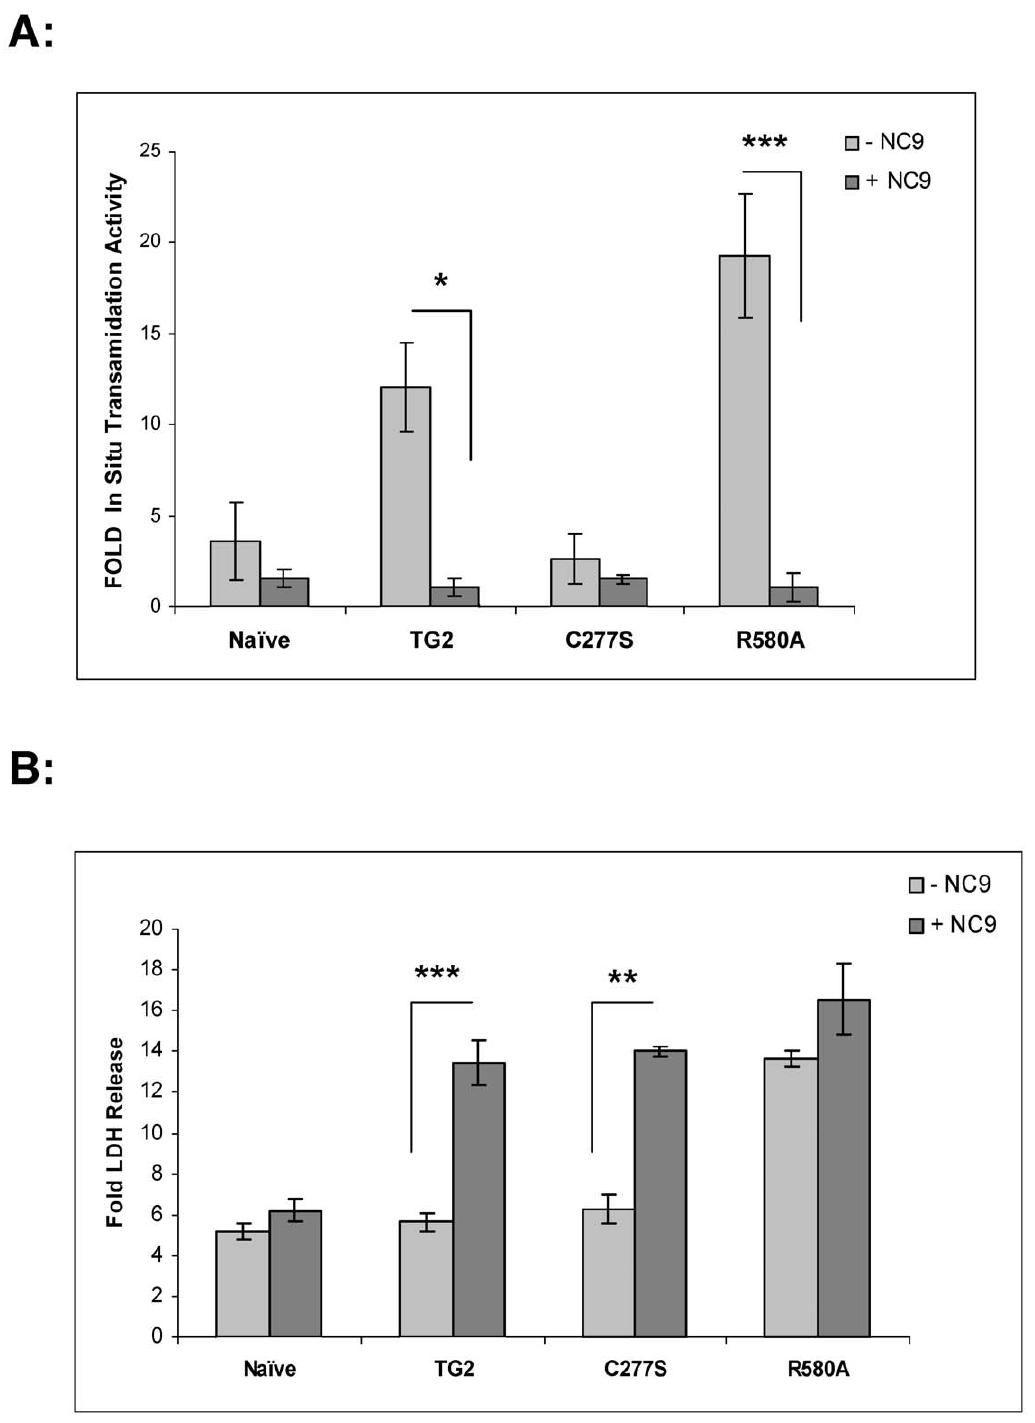
Figure 8. OGD-induced cell death with NC9 treatment. A , Fold in situ transamidation activity with ionomycin treatment in the absence ( 2 ) or presence ( + ) of 10 m M NC9 (Irreversible TG2 inhibitor) in comparison to basal in situ transamidation activity of the corresponding cell line. TG2 cells (12 fold) and TG2-R580A cells (19 fold) showed potentiation of in situ transamidation activity with 5 m M ionomycin treatment which was inhibited 100% by NC9 treatment (N=3). B , Fold LDH release after 36 h of OGD treatment at 0.1% O 2 in the absence ( 2 ) or presence ( + ) of 10 m M NC9 (TG2 inhibitor) in comparison to percent LDH release amount of corresponding cell line at normoxia. TG2 and TG2-C277S (C277S) cells showed significant increases in fold LDH release with NC9 treatment. (N=4) Results are shown as mean + / 2 SE, *p , 0.05, **p , 0.01, ***p , 0.001.